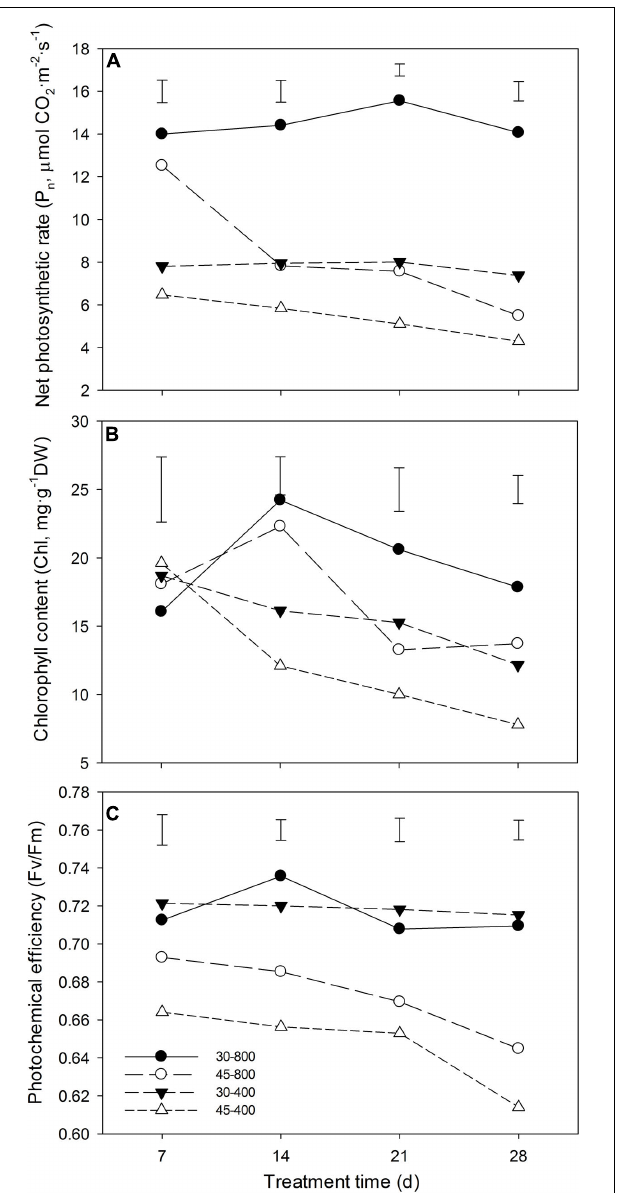
FIGURE 1 | Effects of elevated CO 2 concentration (800 µ mol · mol − 1 vs. 400 µ mol · mol − 1 ) on net photosynthetic rate ( P n ) (A) , chlorophyll content (Chl) (B) and (C) photochemical efficiency ( F v / F m ) in response to heat stress in bermudagrass. The treatments symbols are 30 and 45 for normal temperature control and heat stress and 400 and 800 for ambient CO 2 and elevated CO 2 concentrations, respectively. Vertical bars indicate significant difference based on LSD values ( P ≤ 0.05) for the comparison among treatments.